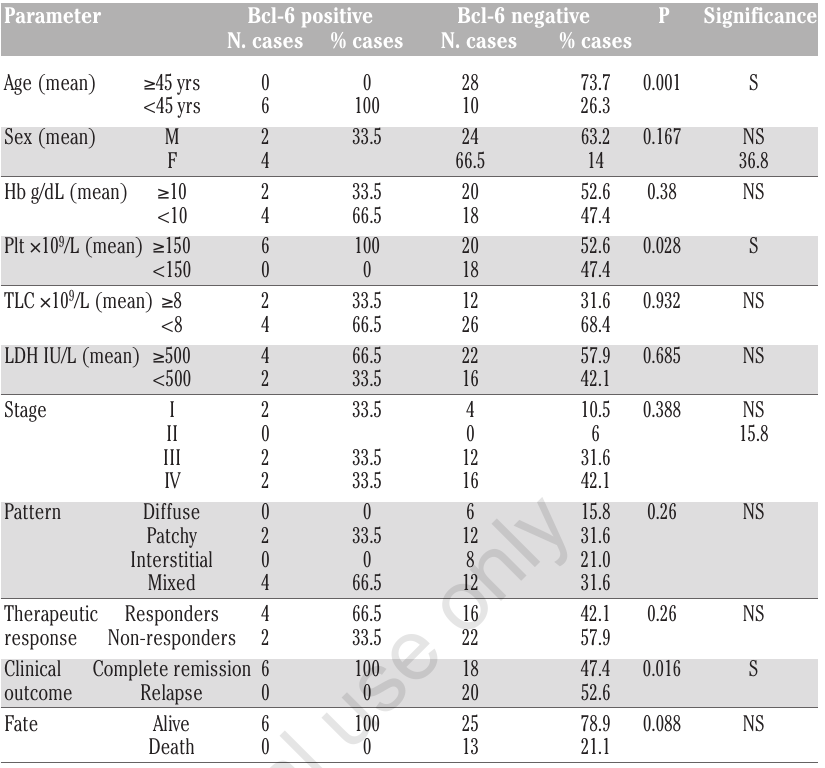
Table 3. Comparing Bcl-6 expression and prognostic parameters in NHL group.